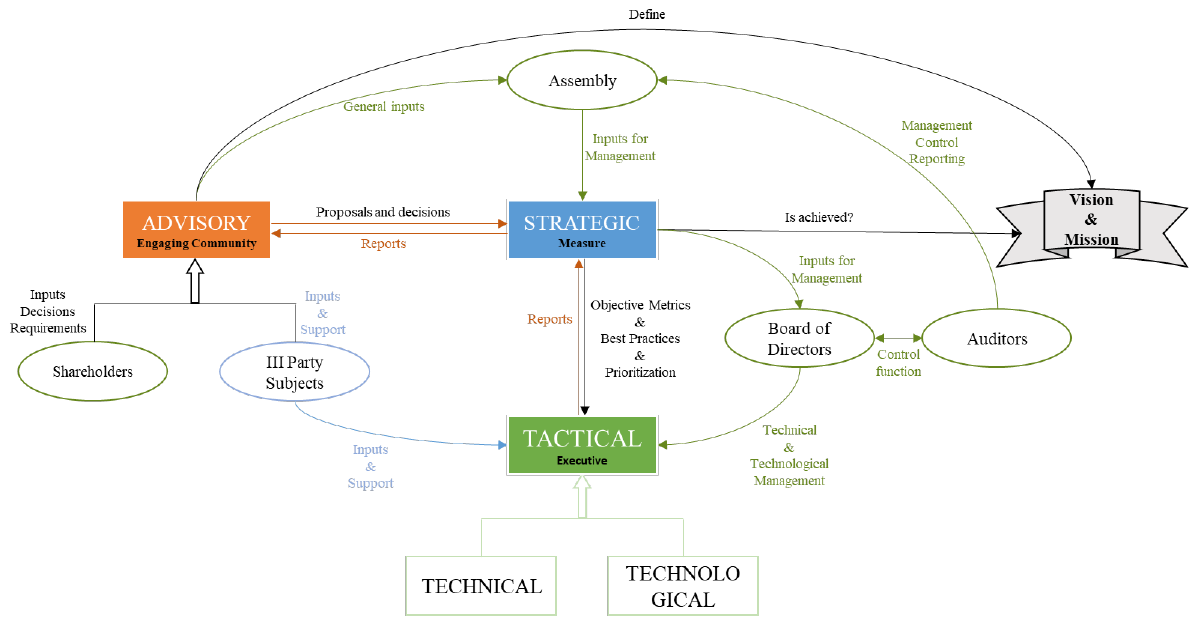
16 Figure 6. Areas and information exchange. The members of the configuration must define the REC mission and vision. The com- munity’s internal governing bodies operate towards fulfilling this mission and vision us- ing internal and external resources, adopting the technical and managerial tools required. The Strategic area serves a pivotal role, as it is responsible for the translation of the needs of the community into specifications, whilst the Tactical area provides the operating solu- tions. The Strategic area is responsible for controlling and reporting activities as well. The proposed model fits Latin, monistic, and dualistic system-based governance models. The authors believe that the Latin model is the preferred one because there is